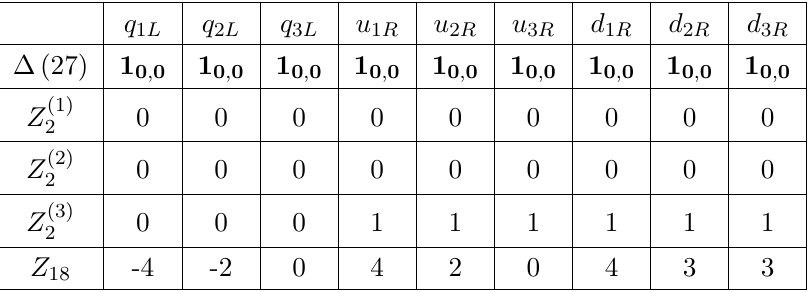
× Z (2) × Z (3) × Z 18 . Superscripts differentiate 2 2 2